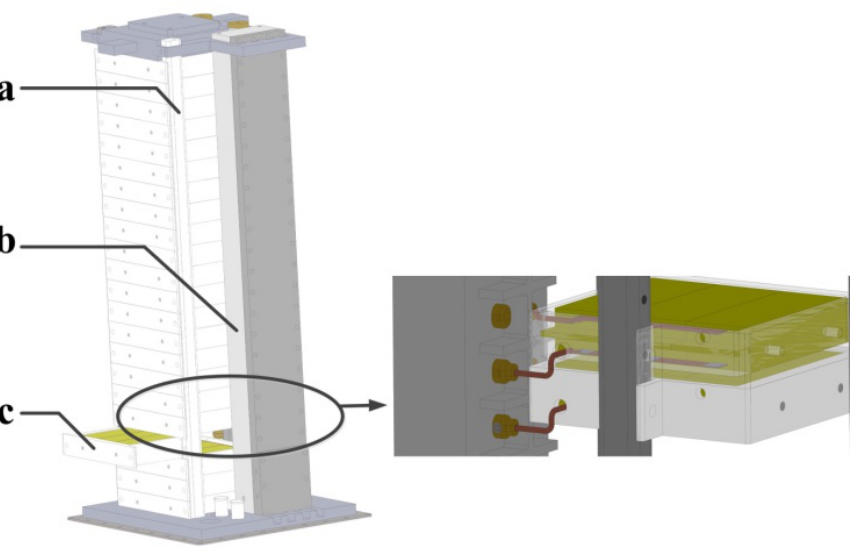
Figure 7. Assembly diagram of the PFN-Marx (a—support rod, b—gas switch, c—PFN module).